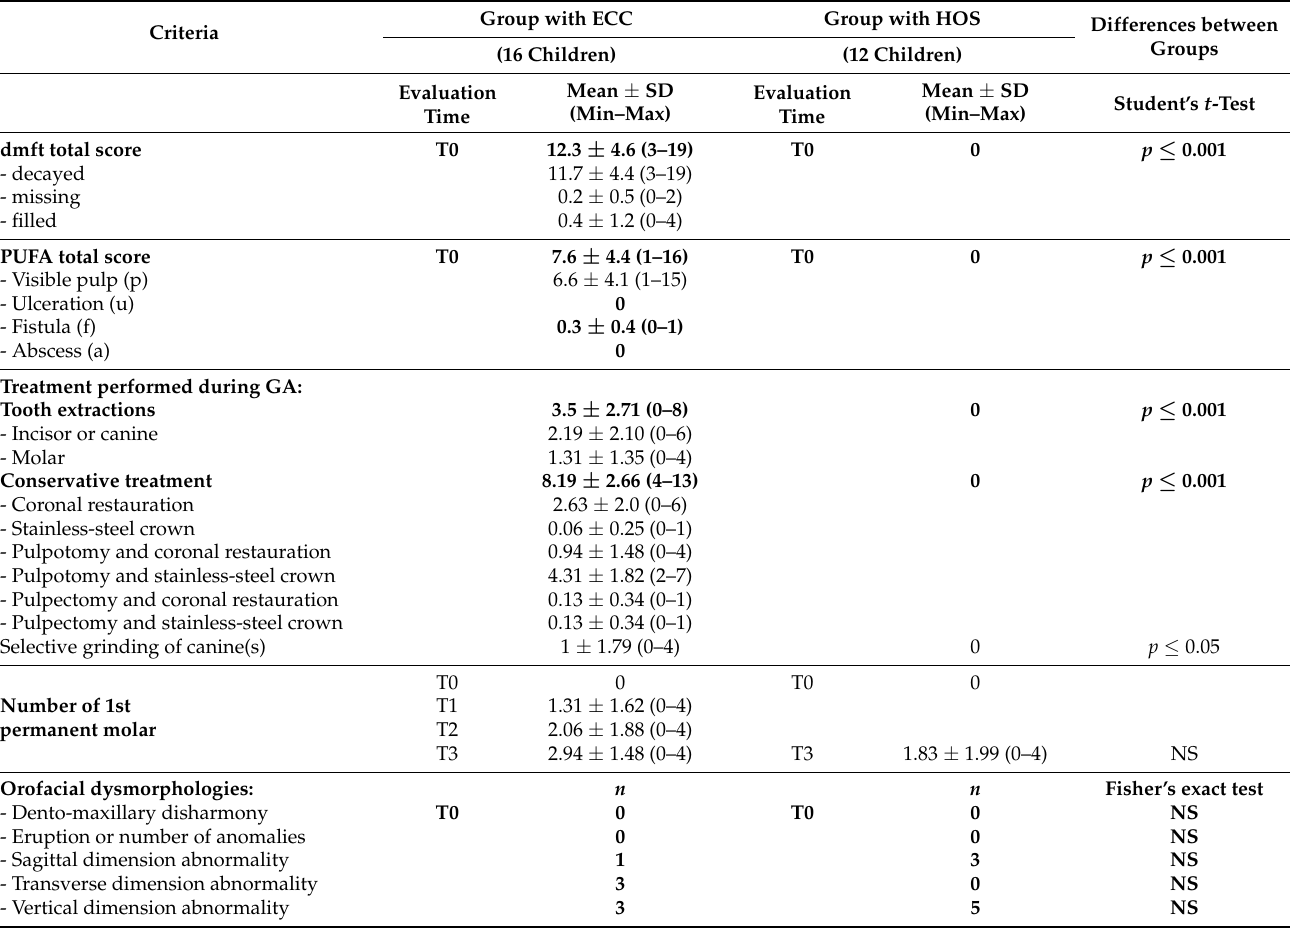
Table 2. Comparative evolution of oral health criteria in both groups of children throughout the